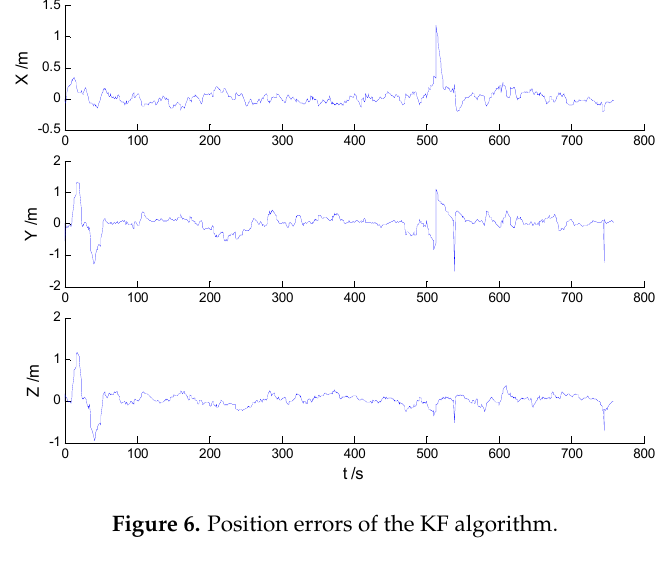
Figure 6. Position errors of the KF algorithm. Sensors 2016 , 16 , 2127